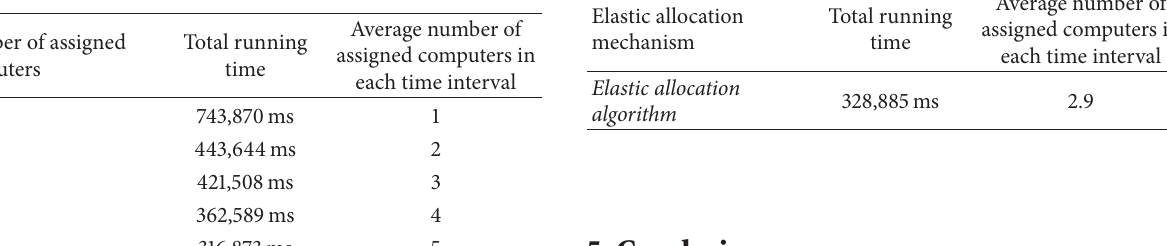
Table 5: The performance of multiple computers running simulta- neously.